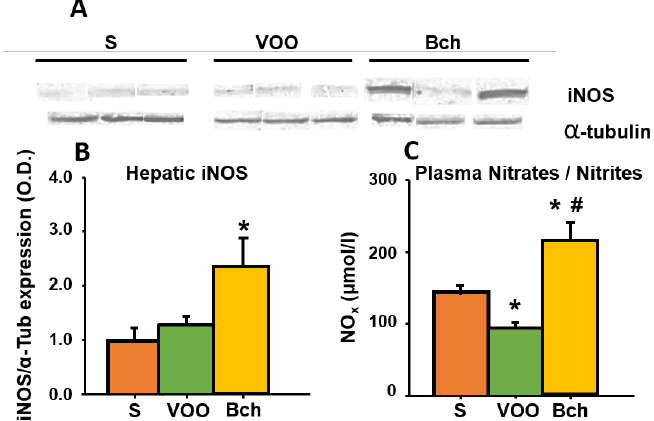
Figure 5. Hepatic inducible nitric oxide synthase (iNOS) measured by using by immunoblots ( A ), mean ±standard error of expression levels of iNOS that were quantified and normalized by the expression of α1-tubulin ( B ), and plasma NOx (NO2- and NO3-) concentration expressed as µmol/L ( C ). S: standard diet, VOO: virgin olive oil diet, Bch: butter plus cholesterol diet. * indicates significant differences between VOO or Bch vs S, * p < 0.05. # indicates significant differences between VOO and Bch, # p < 0.05.